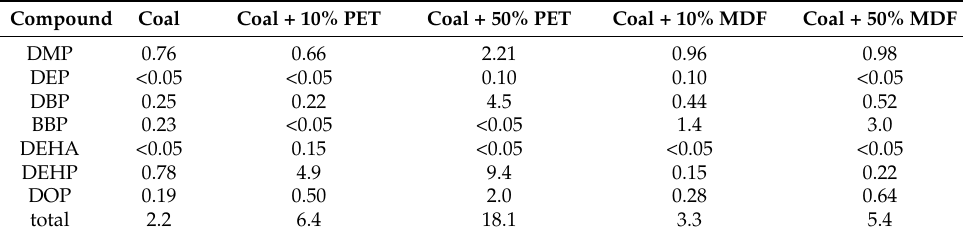
Table 5. Phthalates emission factors